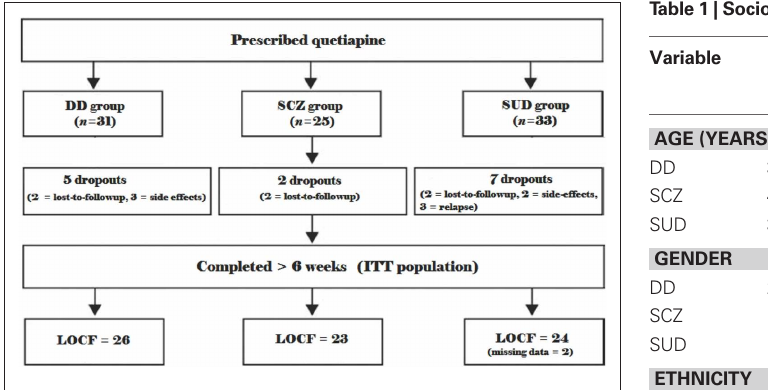
Figure 1 | Participant disposition. ITT, intention-to-treat; LOCF, last- observation carried forward; DD, dual diagnosis group; SCZ, non-abusing schizophrenia group; SUD, non-schizophrenia substance abuser group.